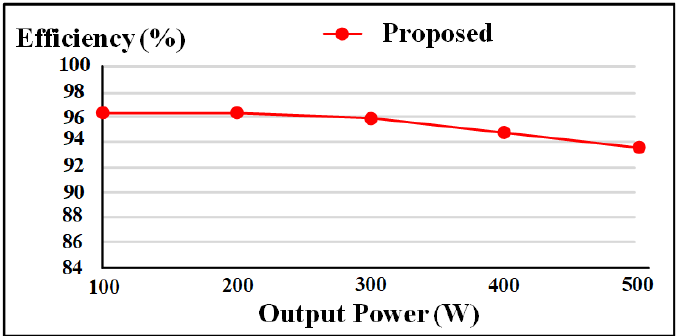
Figure 20. Efficiency curve under step-up mode.